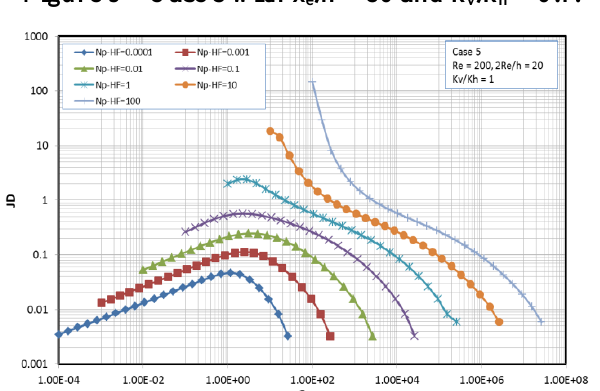
Figure 9—Case 3 with x